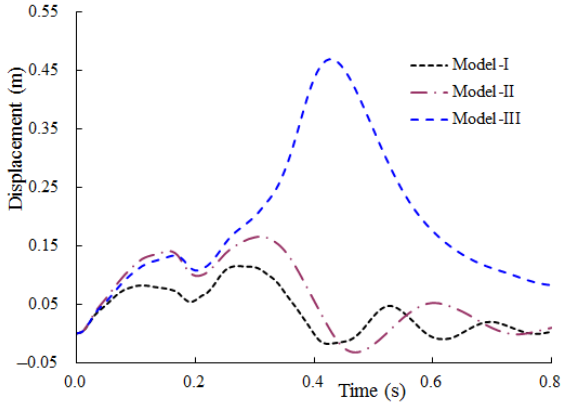
Figure 6. Max displacement time-history of containment.